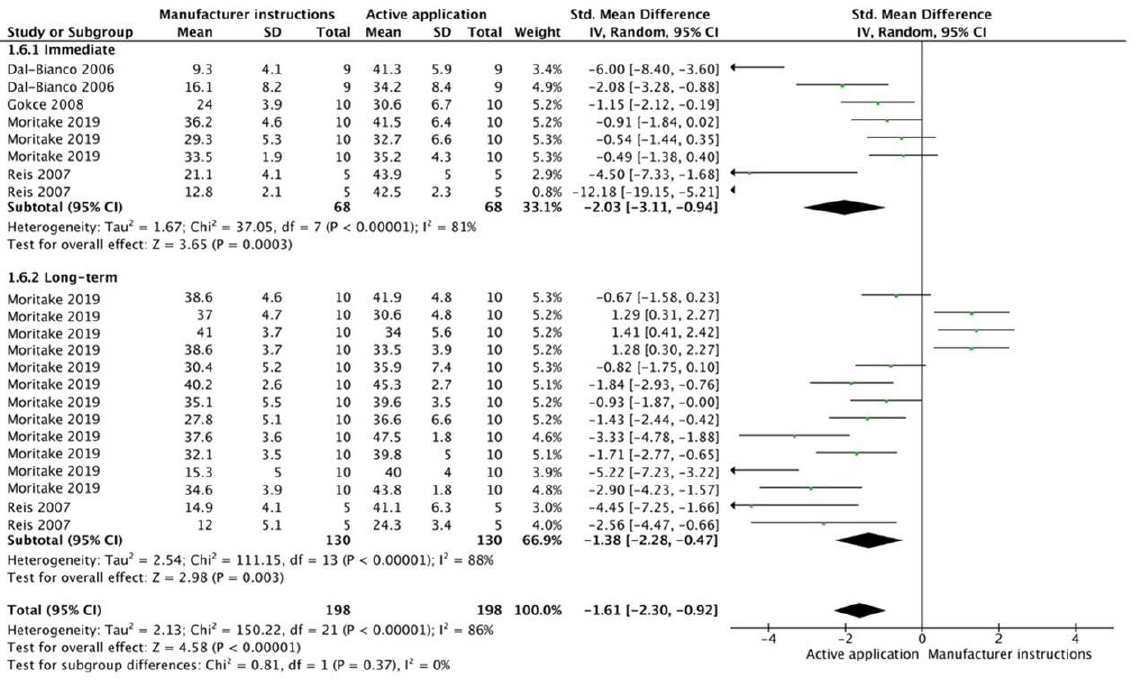
Figure 5. Forest plot showing the bond strength values when the adhesive was applied using an electric current.